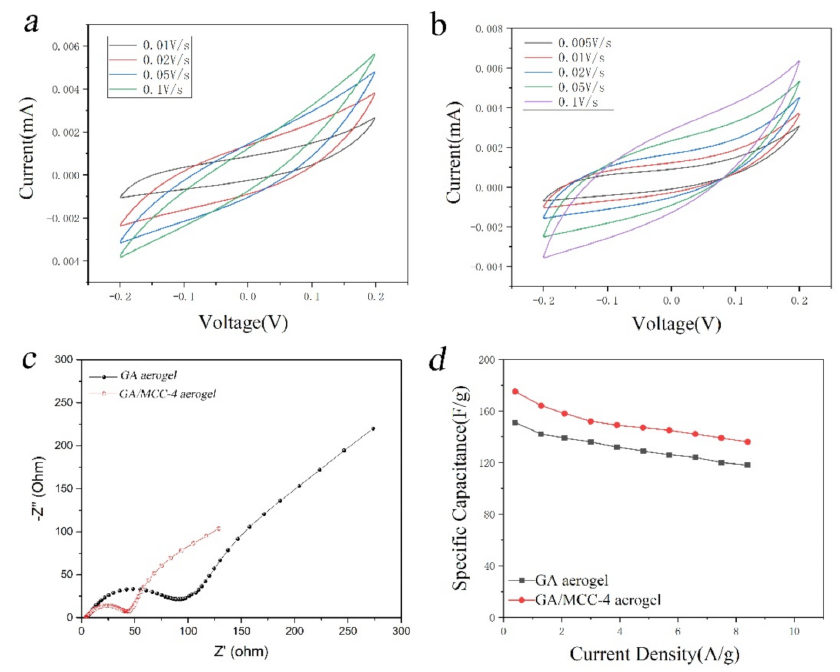
Figure 8. Comparison of GA aerogel and GA-MCC-4 aerogel in a three-electrode system with 6 M KOH as the electrolyte. ( a ) CV curves of GA aerogel at different scan rates. ( b ) CV curves of GA-MCC- 4 aerogel at different scan rates. ( c ) The Nyquist impedance plots of the GA aerogel and GA-MCC-4 aerogel. ( d ) Specific capacitance retention of GA aerogel and GA-MCC-4